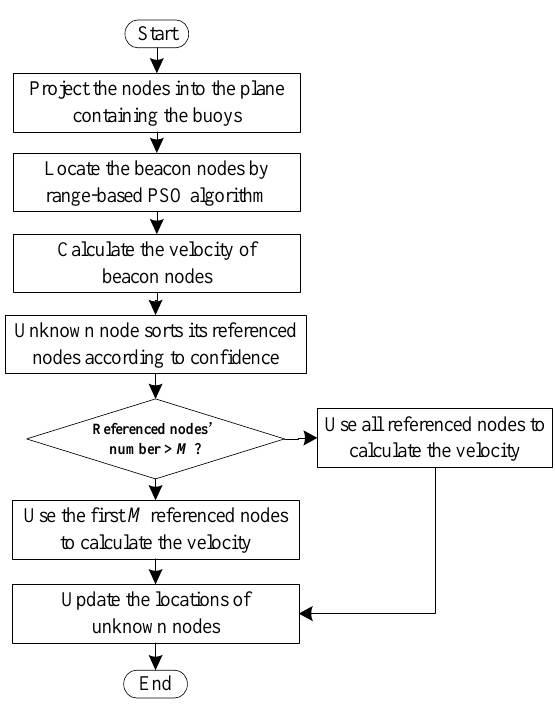
Figure 6. The process of MP-PSO algorithm.